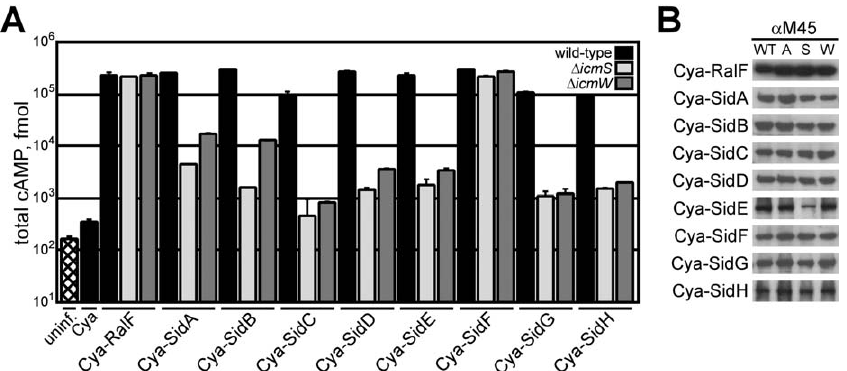
Figure 1. The IcmSW Complex Is Necessary for the Translocation of Multiple Effector Proteins (A) CHO Fc c RII cells were left uninfected (hatch), or infected with wild-type (black), D icmS (light grey), or D icmW (dark grey) L. pneumophila strains expressing the indicated Cya hybrid proteins. After 1 h of infection, tissue culture cells were lysed and cAMP was extracted from the sample. Total cAMP production induced by translocation of the hybrid was quantified using an enzyme-immunoassay system, indicated as fmol. Results represent average values 6 SD of experiments performed in triplicate. (B) Immunoblots of whole-cell bacterial extracts expressing indicated Cya hybrid proteins from wild-type (WT), D dotA (A), D icmS (S), and D icmW (W) probed with monoclonal antibody specific to the M45